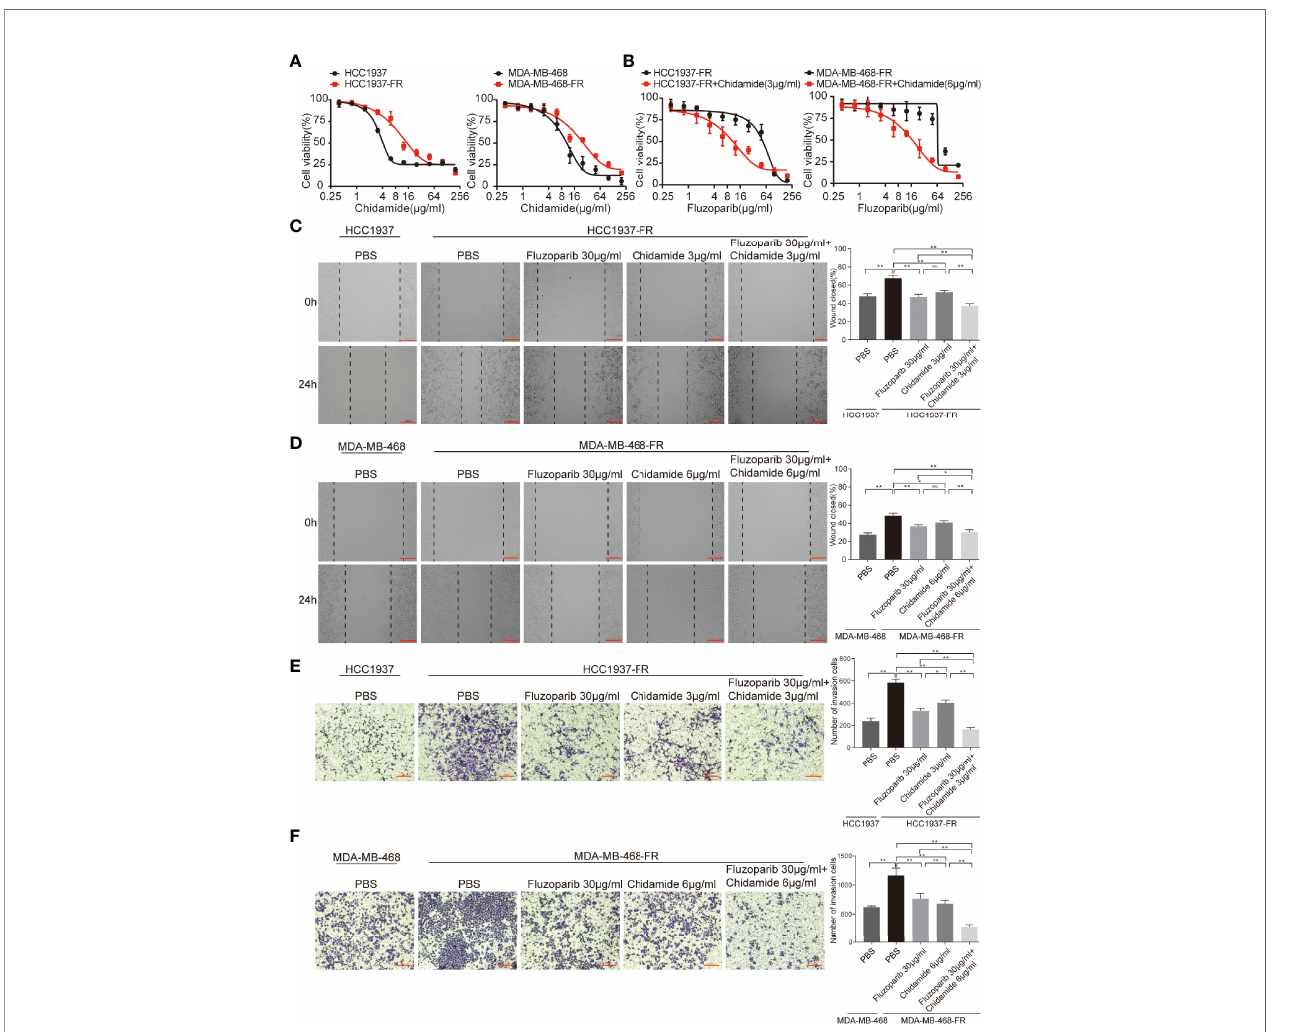
FIGURE 2 | Effects of chidamide and fl uzoparib on cell migration. (A) Dose-response curves of parental and fl uzoparib-resistant cells treated with different concentrations of chidamide for 48 h. (B) Dose-response curves of parental and fl uzoparib-resistant cells treated with different concentrations of fl uzoparib combined with 3 or 6 m g/ml of chidamide. (C, D) Wound-healing assay to assess the effects of fl uzoparib and chidamide on parental and fl uzoparib-resistant HCC1937 and MDA-MB-468 cell migration ability. (E, F) Transwell invasion assays assessed the effects of fl uzoparib and chidamide on parental and fl uzoparib-resistant HCC1937 and MDA-MB-468 invasiveness. Data represent the mean ± SD of three independent experiments. * p < 0.05; ** p < 0.01. No, no signi fi cance.